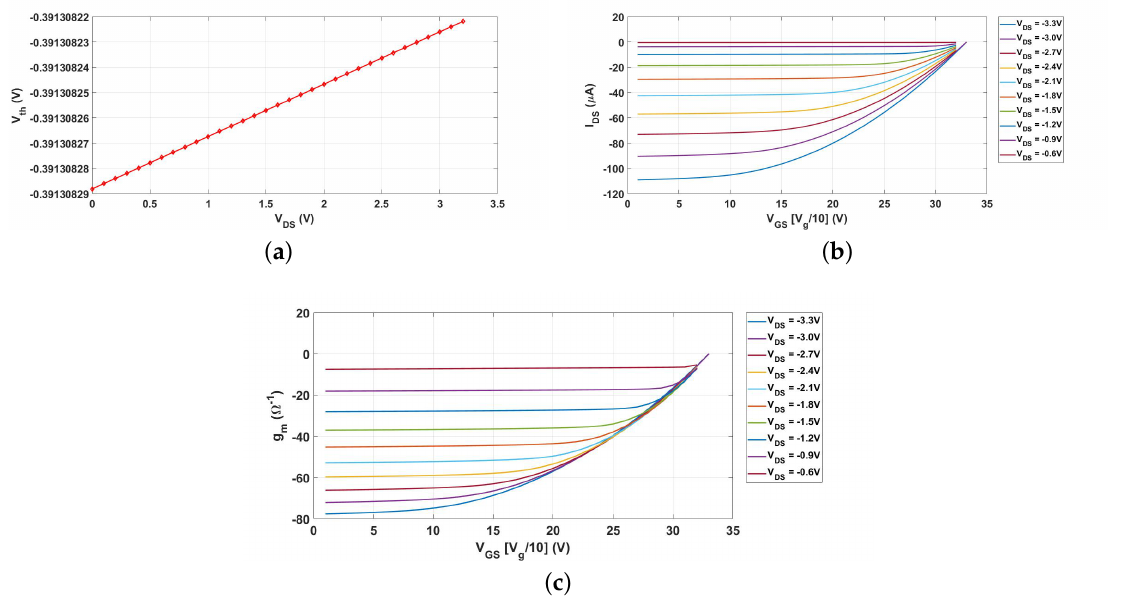
Figure 13. BSIM3v3 I-V model results. ( a ) Threshold voltage modified by drain-source and gate-source voltage, ( b ) I-V curves, and ( c ) the transistor’s transconductance for UMC 0.18- µ m pMOS